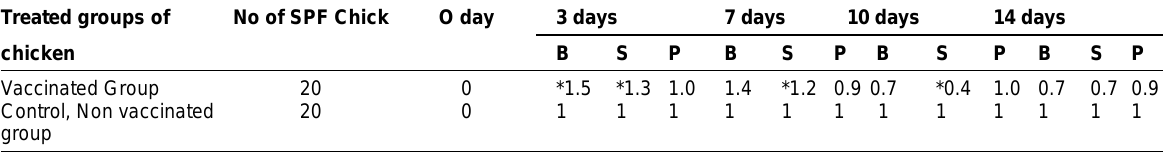
Table-3. The effect of TCIBD variant vaccine on organs /body weight Treated groups of